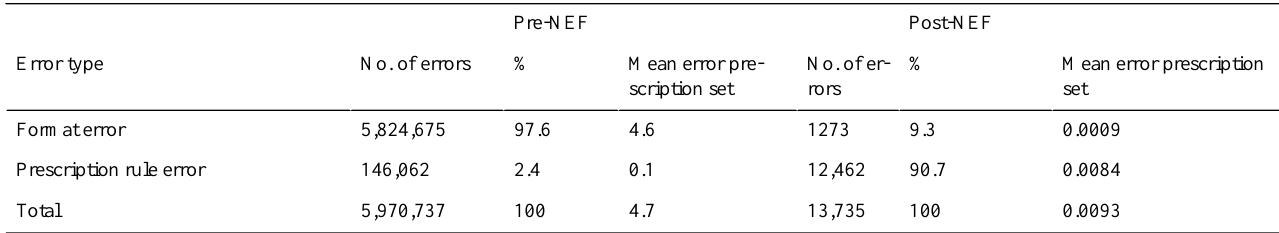
Table 8. Number of errors and mean error per prescription set. Post-NEFPre-NEF